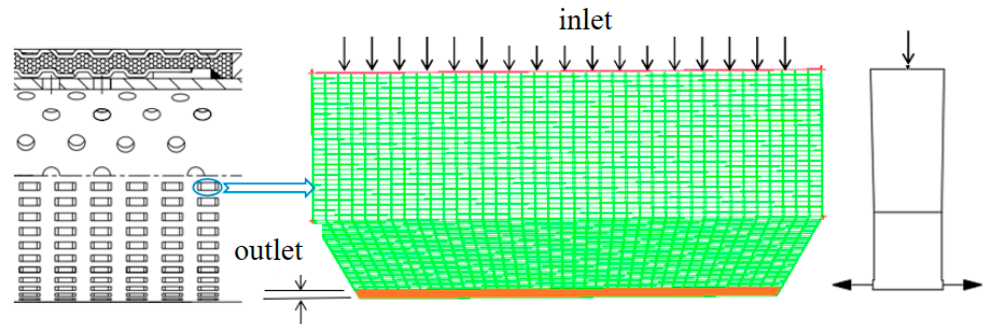
Figure 4. Schematic diagram of flow channel grid of single slit screen.